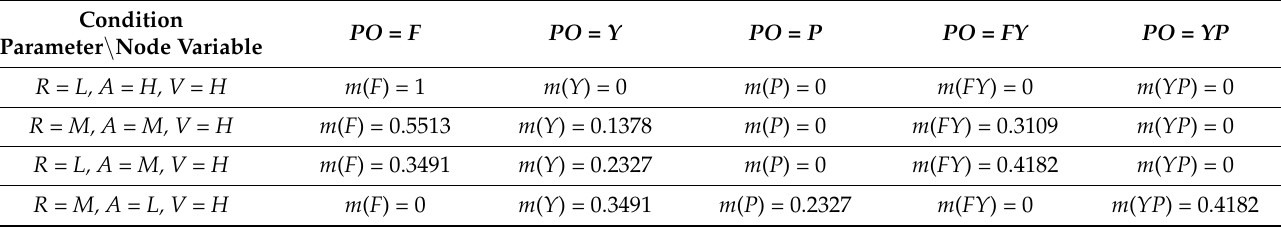
Table 2. Conditional belief parameters of node PO .